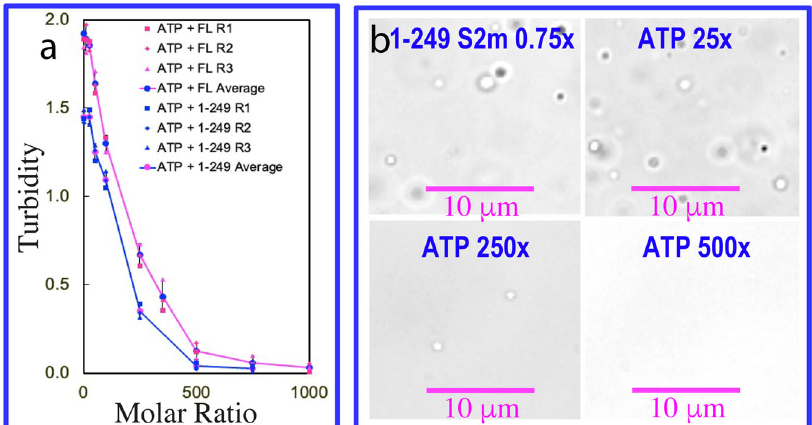
Fig. 5 ATP dissolves LLPS of N (1-249) induced by S2m. a Turbidity curves of the average values of three repeated measurements ( n = 3) with STD displayed as error bars of the full-length N protein and N (1-249) in the presence of S2m at 1:0.75 with additional addition of ATP at different ratios. b DIC images of N (1-249) in the presence of S2m at 1:0.75 with additional addition of ATP at different ratios.